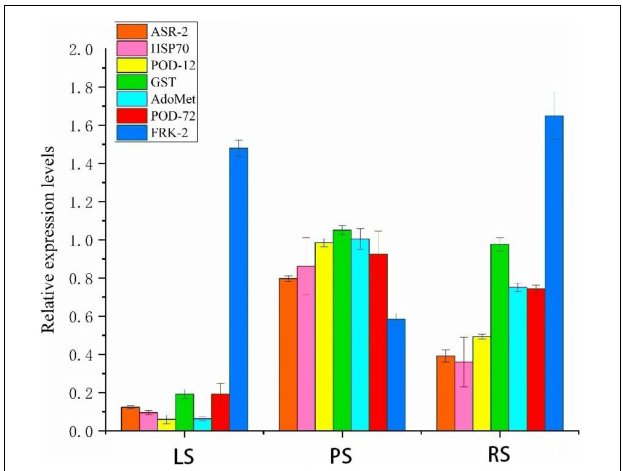
FIGURE 9 | Complementation of isobaric tags for relative and absolute quantitation (iTRAQ) results by real-time quantitative PCR (qRT-PCR). Values represent the means ± SE ( n = 3). ASR-2, aquaporin PIP1 2b; HSP70, heat shock protein 70; POD-12, peroxidase 12-like; GST, probable